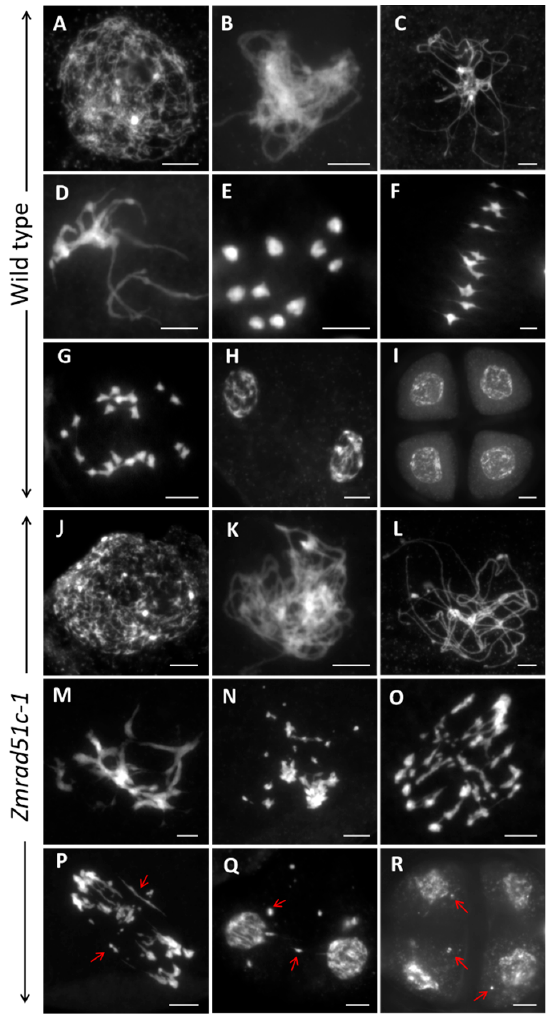
Figure 3. Male meiotic chromosome behaviors in wild type and Zmrad51c-1 meiocytes. ( A – I ) Meiosis in wild type. ( A ) Leptotene; ( B ) zygotene; ( C ) pachytene; ( D ) late pachytene; ( E ) diakinesis; ( F ) metaphase I; ( G ) anaphase I; ( H ) telophase; ( I ) tetrads. ( J – R ) Meiosis in Zmrad51c-1 . ( J ) leptotene; ( K ) zygotene; ( L ) pachytene; ( M ) late pachytene; ( N ) diakinesis; ( O ) metaphase I; ( P ) anaphase I; ( Q ) telophase; ( R ) tetrads. The red arrows indicated the abnormal chromosomal fragments, bridges, and micronuclei. Scale bars = 10 µm.